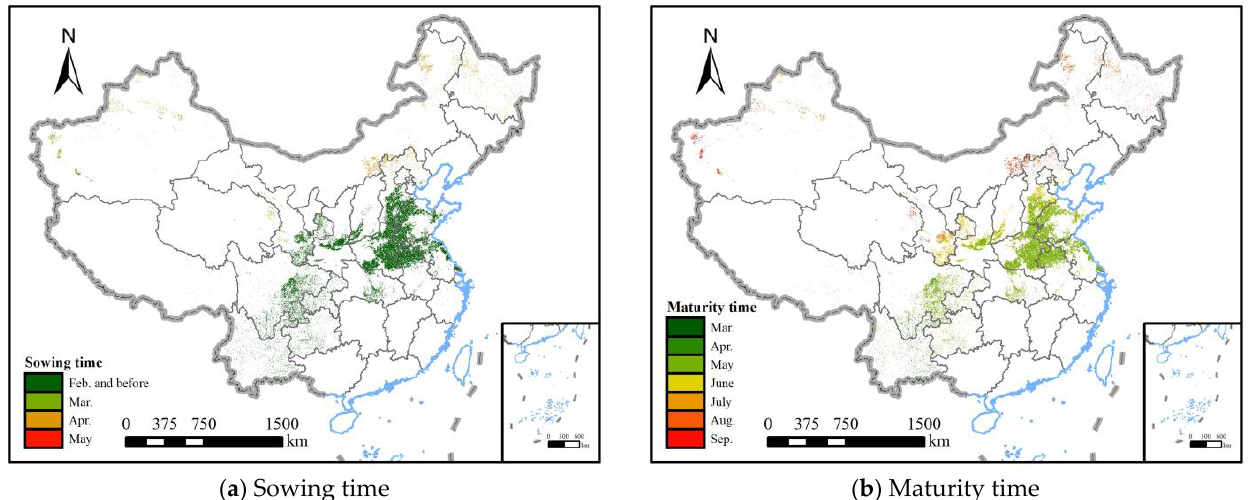
Figure 2. The month of sowing and maturity of wheat in China from 2010 to 2014; ( a ) sowing time; ( b ) maturity time.